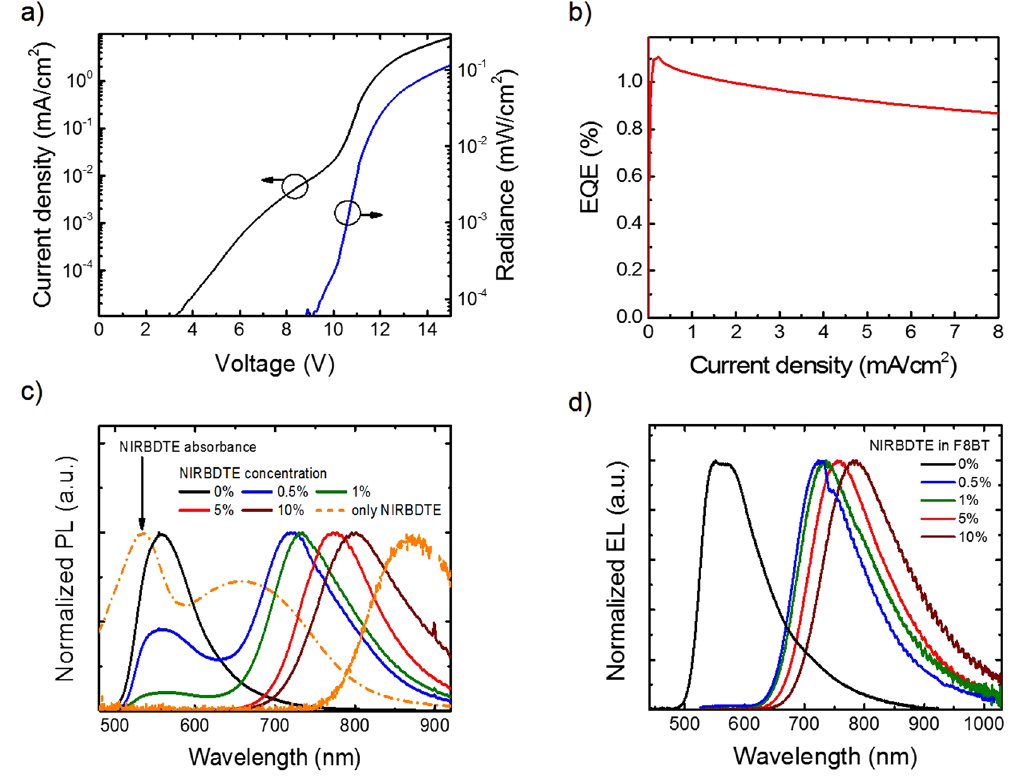
Figure 2. ( a ) J-V-R curves and ( b ) EQE of PLED incorporating the blend of F8BT with the NIRBDTE at 0.5% wt. ( c ) PL spectra (excited at 450 nm) of the solid films incorporating different NIRBDTE concentration in the host F8BT and the EL spectra of PLEDs incorporating these films as emissive